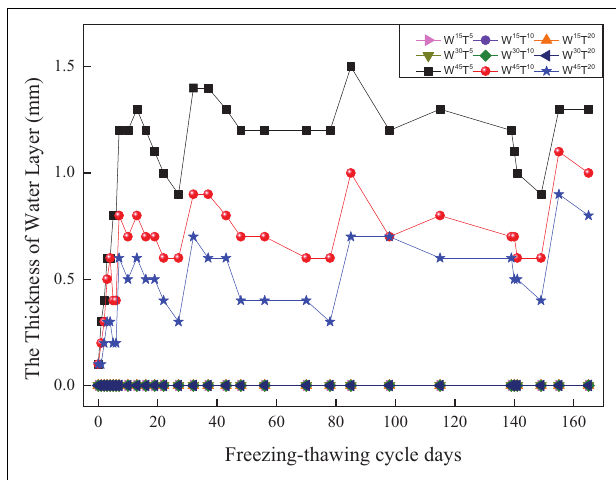
FIGURE 7 | The thickness of water layer above the surface soil during the freezing–thawing